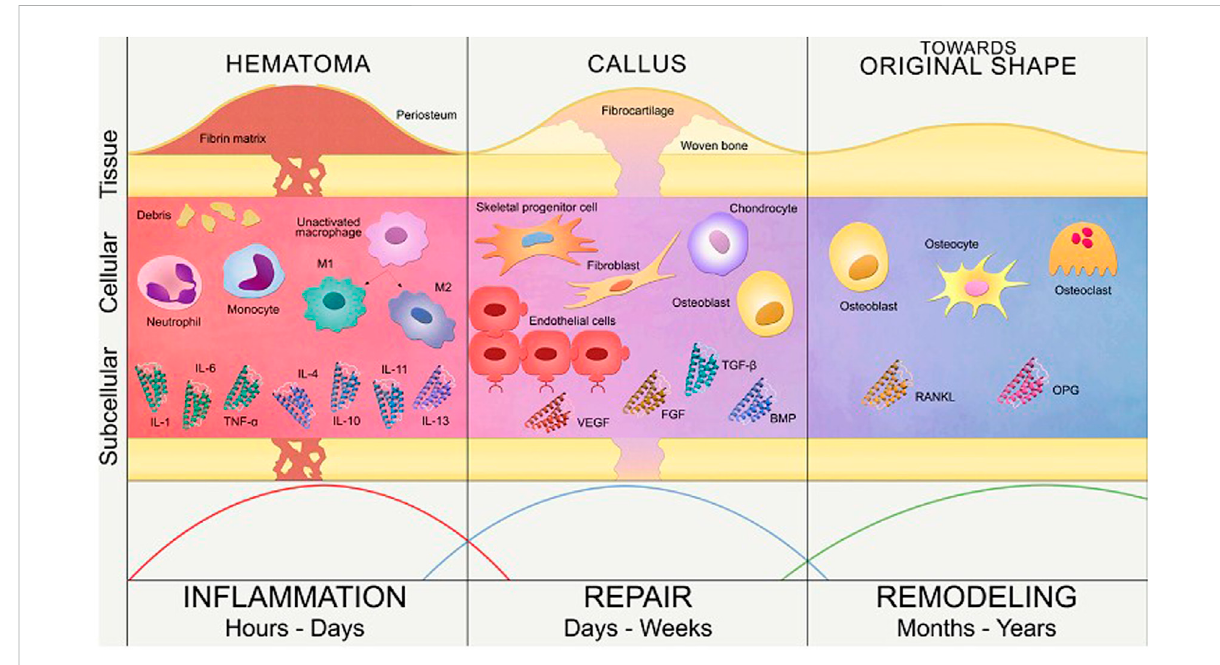
FIGURE 2 Phases of bone healing in the subcellular, cellular and tissue level (Reproduced with permission from Ref (Lafuente-Gracia et al., 2021) under Creative Commons Attribution License (CC